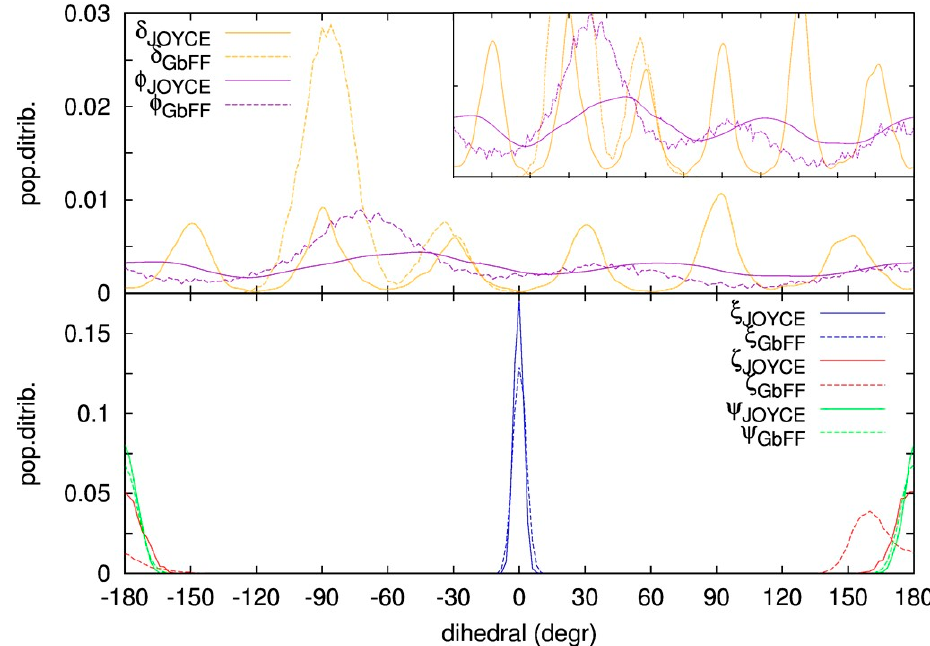
Figure 4. Distribution of flexible (top) and stiff (bottom) dihedral angles as defined in Figure 2c–f, during the MD runs performed with J OYCE (continuous) and GbFF (dashed line) methods. In the top panel an insert caption of the graph with a lower y-scale is displayed on the top right part for the sake of visualization of the periodicity for the ϕ .